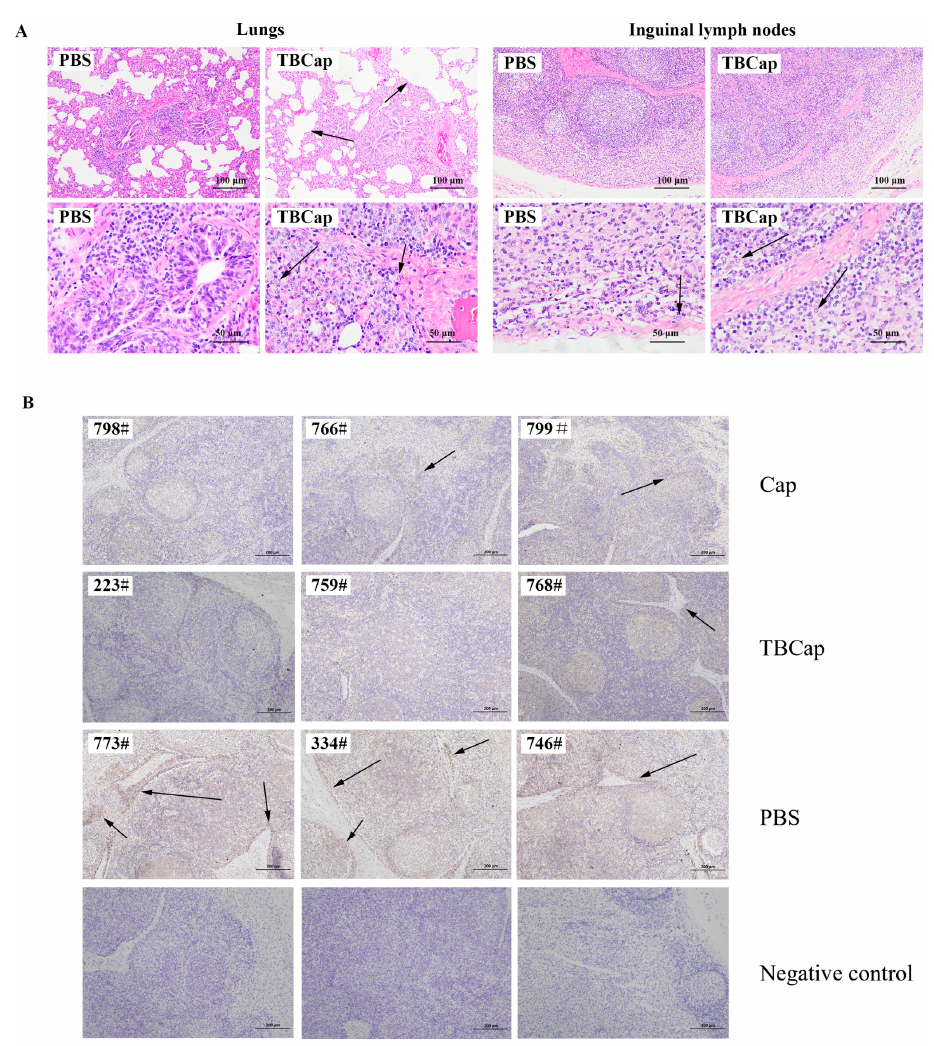
Figure 6. Histopathological testing of piglets after challenge. ( A ) HE staining of piglet lung and inguinal lymph node tissue. ( B ) IHC of inguinal lymph node tissue in piglets, black arrows indicate tan-colored cells in the inguinal lymph node tissue.